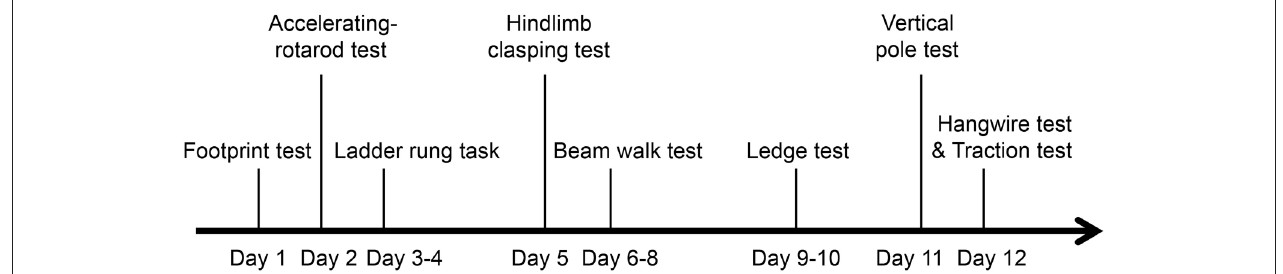
FIGURE 1 | Experimental paradigm of behavioral tests for assessing motor